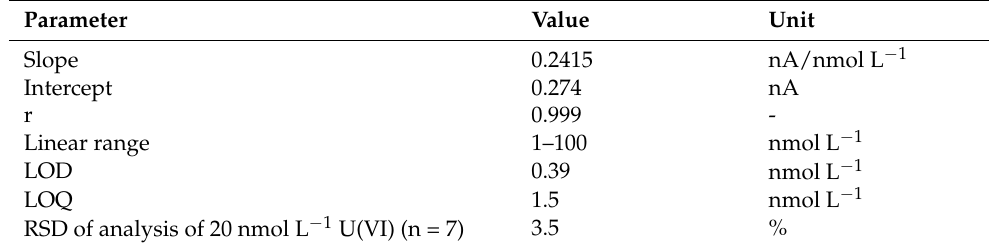
Table 1. Analytical features of the developed procedure. Parameter